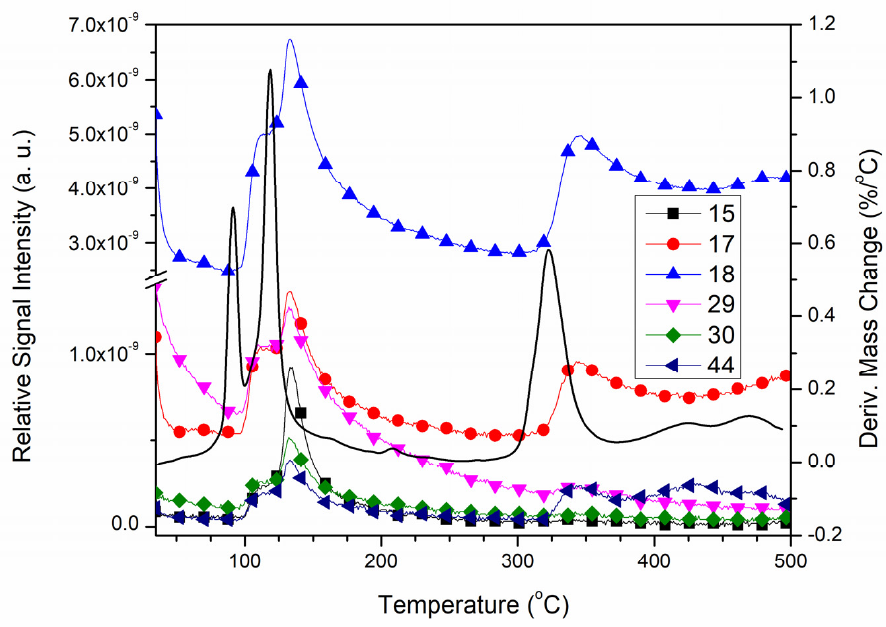
Figure 6. TG–MS signals of fragments evolved from H 4 L during heating in argon.